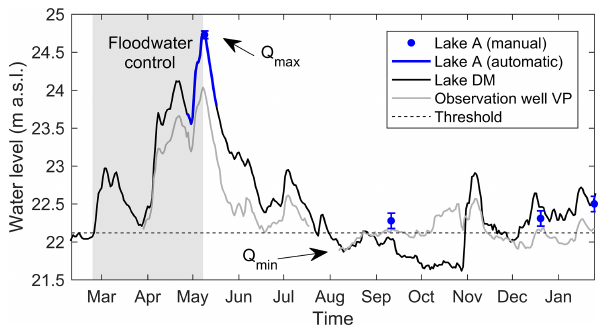
Figure 2. Daily mean water levels at lake A, lake DM, and obser- vation well VP from 9 February 2017 to 25 January 2018. The grey shaded area corresponds to the floodwater control period. Q max and Q min indicate the timing of the adjusted maximum and minimum output from the